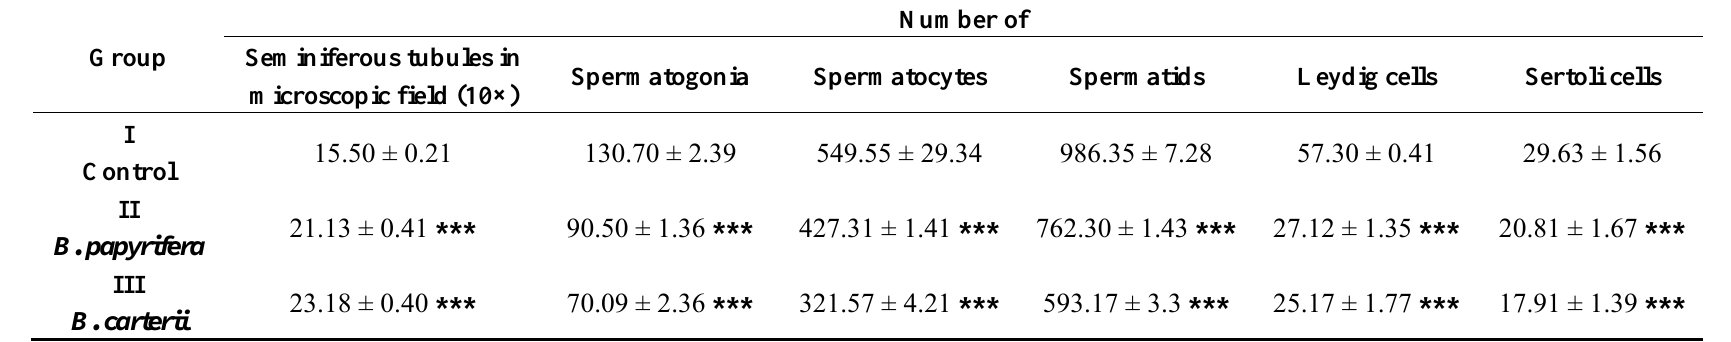
Table 2. Effect B. carterii and B. papyrifera smoke exposure on total count of seminiferous tubules, germ cells, Leydig cells and Sertoli cells in the testis of albino